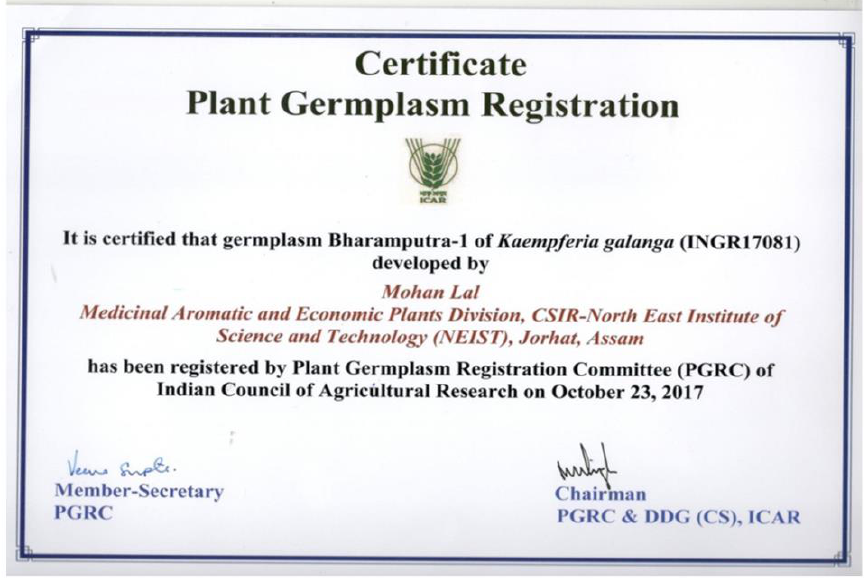
Figure 1. Germplasm registration certificate of Bharamputra-1 by the NBPGR, New